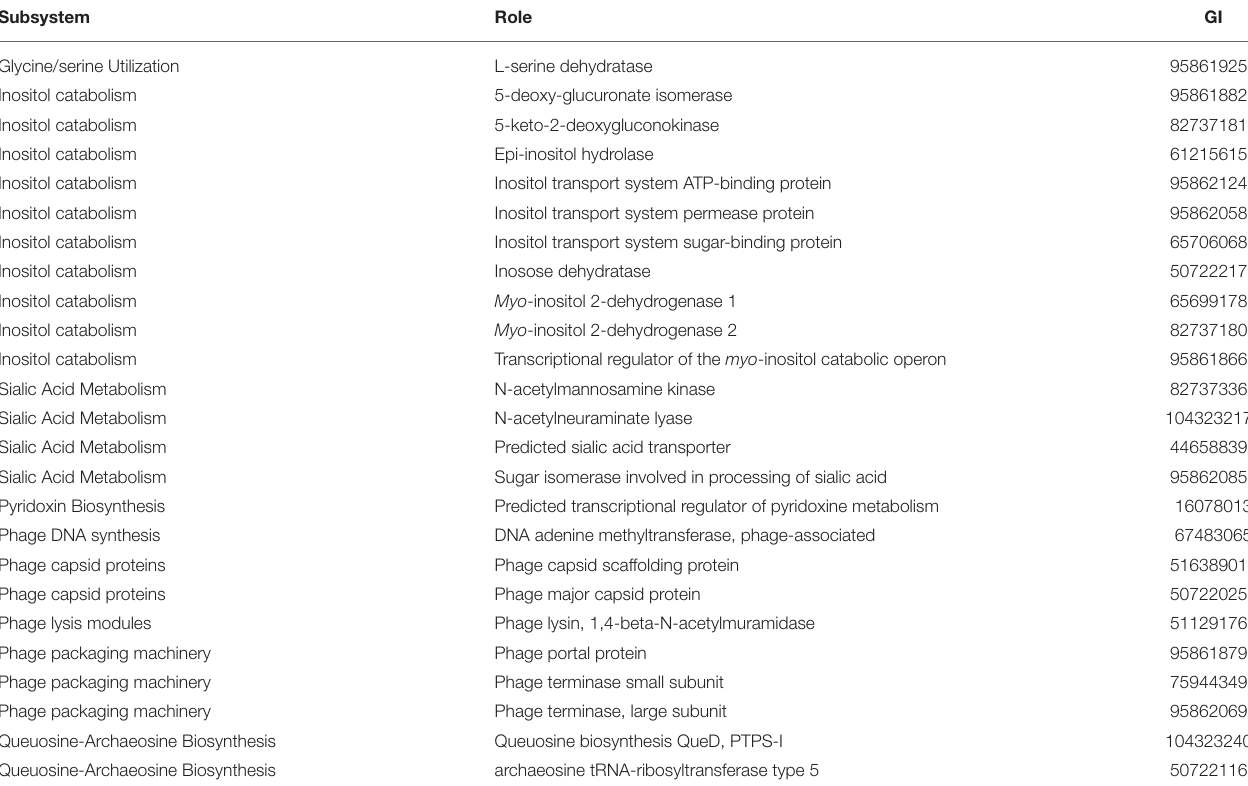
TABLE 4 | Virulence factors that are unique to vAh strains, based on a comparison of significant BLASTn hits between A. hydrophila isolates against the RAST/SEED database.